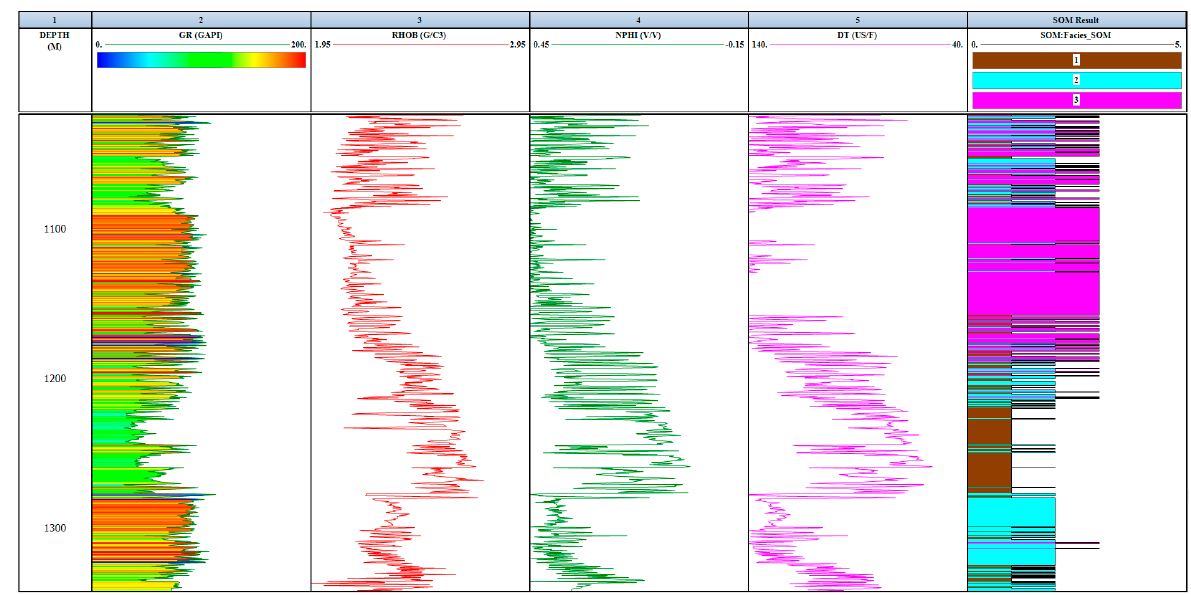
Figure 8. Well 03 SOM facies vertical dispersions inside the zone of interest.